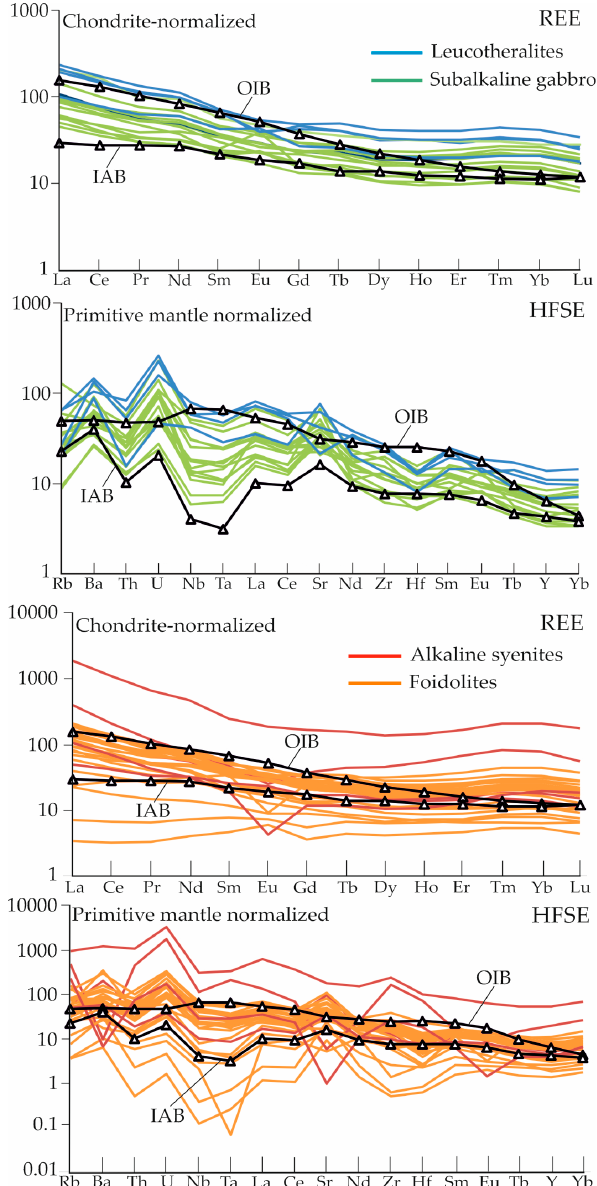
Figure 8. Chondrite-normalized rare earth elements (REE) and primitive mantle normalized high-field-strength elements (HFSE) [69] igneous rocks of the University pluton. The oceanic island basalt (OIB) spectrum line is given in [69], island arc basalt (IAB) in [70]. Subalkaline gabbro ca. 490 Ma; leucotheralites (there is no data on age, but we link their formation with N-S dikes of ca. 390 Ma); alkaline syenites and foidolites ca. 390